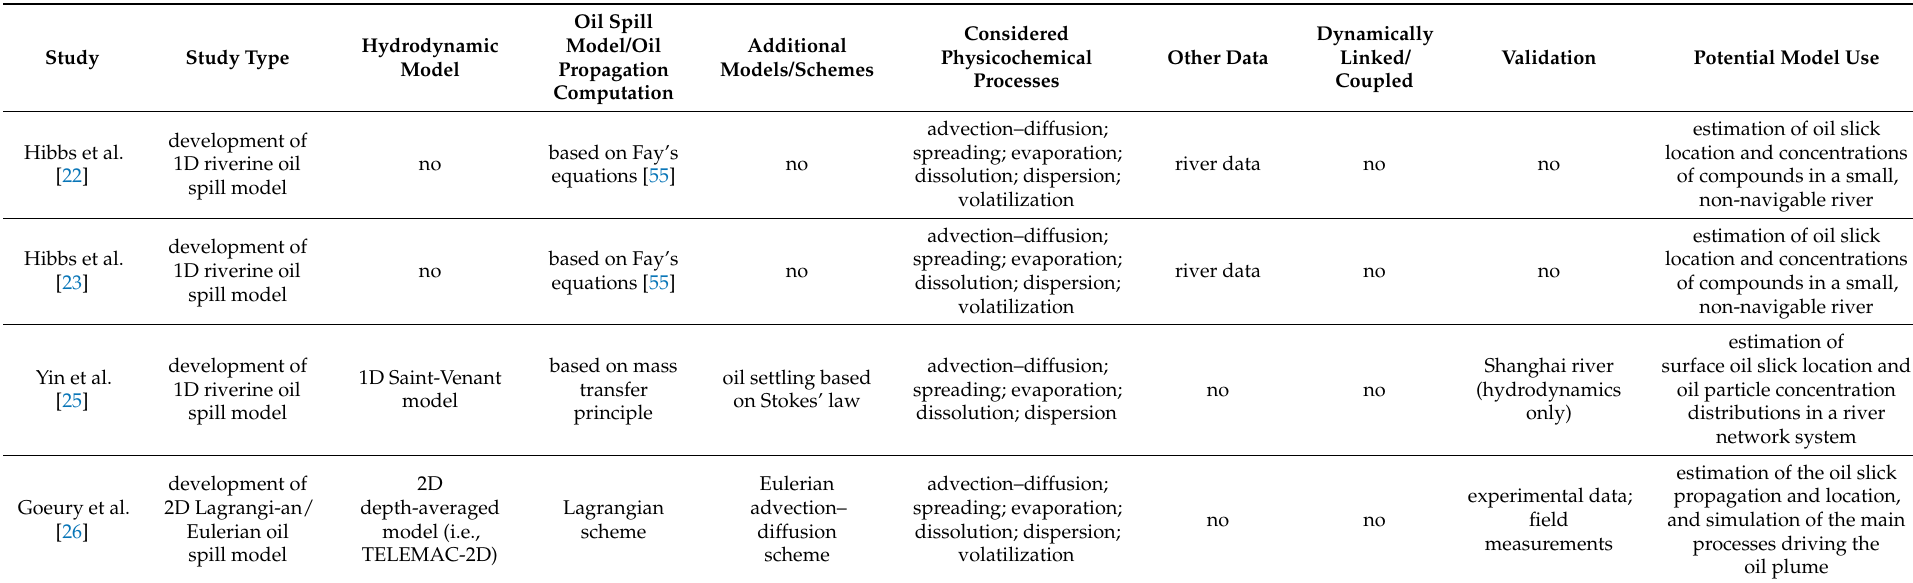
Table 1. Development of numerical